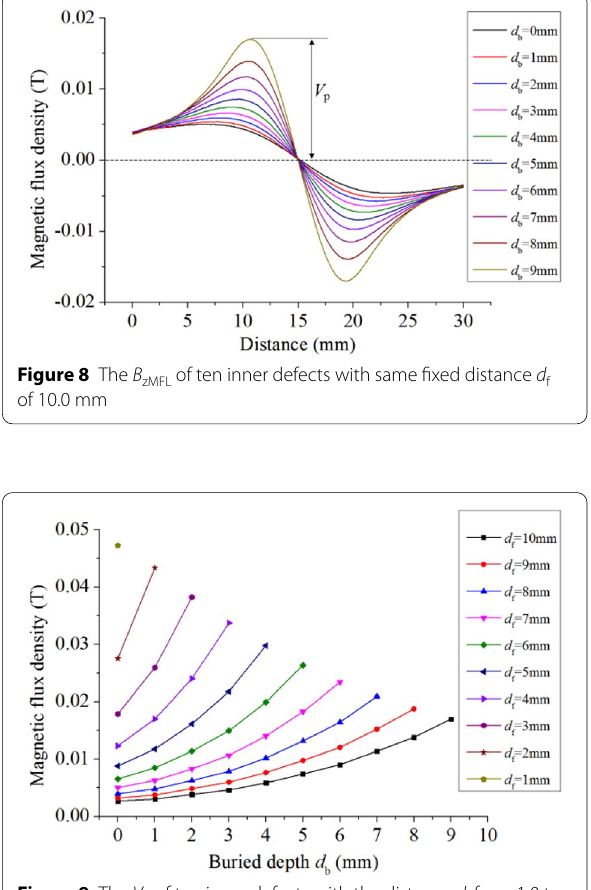
Figure 9 The V p of ten inner defects with the distance d f from 1.0 to 10.0 mm